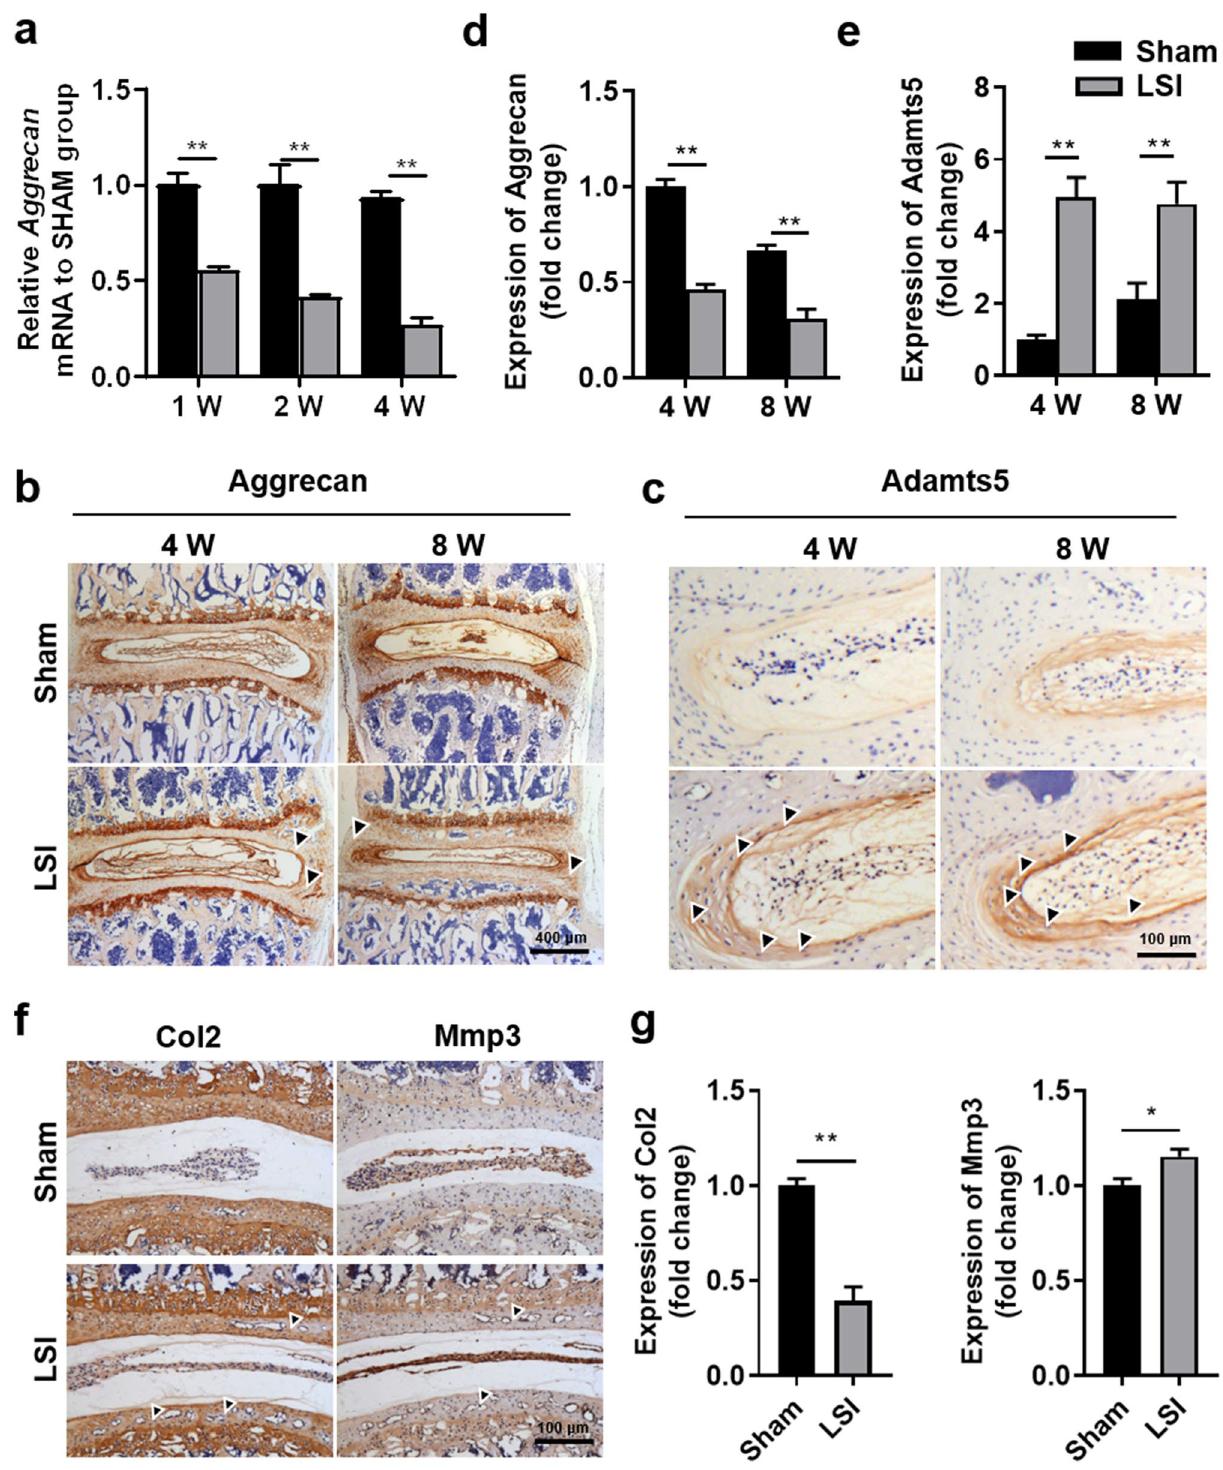
Figure 3. Aberrant mechanical stress resulted in matrix composition changes in the intervertebral disc. ( a ) Immunostaining for Aggrecan in the IVD (brown) at 4-, 8-W post-surgery. Hematoxylin stains nuclei purple. Black arrowheads indicate low expression of Aggrecan in AF. ( b ) Immunostaining for Adamts5 in the AF (brown) at 4-, 8-W post-surgery. Black arrowheads indicate the high expression of Aggrecan in AF. ( c ) qPCR analysis for Aggrecan mRNA in the IVD at 1-, 2- and 4-W post-surgery. ( d ) Quantification of Aggrecan expression in IVD of ( a ). ( e ) Quantification of Adamts5 expression in IVD of ( b ). ( f ) Immunostaining for Col2 and MMP3 (brown) at 8-W post-surgery. Black arrowheads indicate low expression of Col2 in EP or high expression of Mmp3 in EP. ( g ) Quantification of Col2 and Mmp3 expression in EP region of ( e ). The averages of integrated optical density in interest region was calculated by Image-Pro Plus software version 6.0 (https ://www.media cy.com). Data are shown as mean ± sem. Three independent experiments were performed in triplicate. * P < 0.05, ** P < 0.01 compared to Sham